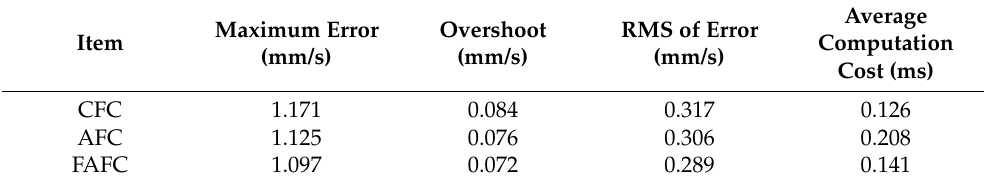
Table 5. Performance of CFC, AFC, and FAFC under Case (200, 105, 194, 25).